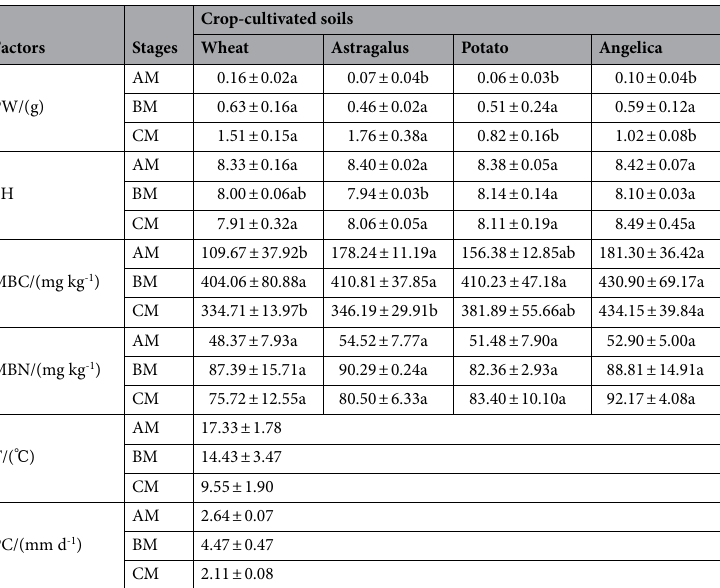
Table 1. Effect of crop-cultivated soils on ecological factors during the growth stage. Data are presented as standard deviation (SD), n = 3. Different lowercase letters represented statistically significant differences among crop-cultivated soils by One-ANOVA with Tukey’s test at P < 0.05. AM, BM, and CM represented the different growth stages at 56 days, 98 days, and 129 days respectively. PW the plant weight, pH the soil pH, MBC the microbial biomass C, MBN the microbial biomass N, T the climate temperature, PC the